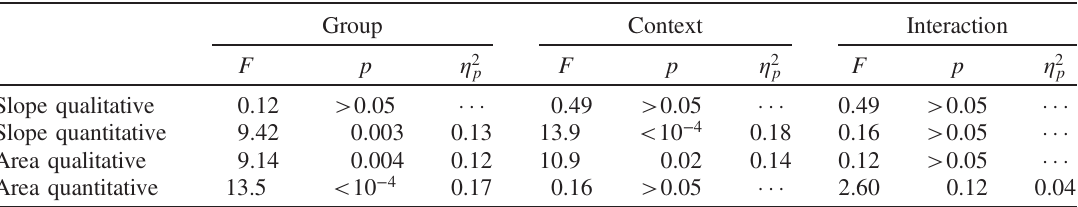
TABLE II. Results of the two-way ANOVAs conducted on students ’ scores with the context (physics vs finance) as a within-subject factor and with the group (physics students vs economics students) as a between-subject